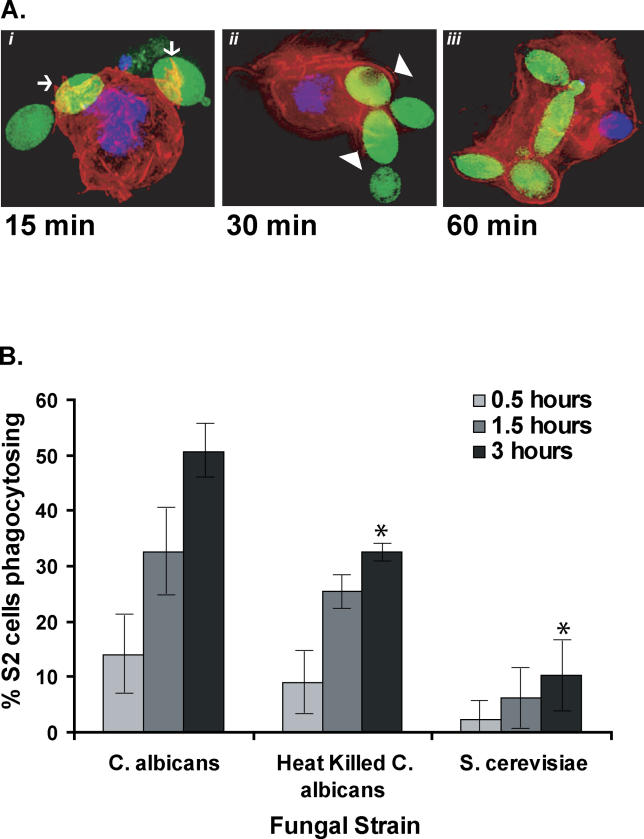
Phagocytosis of C. albicans by Drosophila S2 Cells(A) The Drosophila hemocyte-like S2 cell line phagocytoses C. albicans. S2 cells were co-incubated with GFP expressing C. albicans for the indicated times. Cells were fixed, and the filamentous actin of S2 cells was stained with rhodamine phalloidin and the S2 cell DNA with Hoechst 33258.(B) Quantification of phagocytosis of C. albicans and S. cerevisiae by S2 cells. S2 cells and the indicated fungal strain were co-incubated for various times, and the percentage of S2 cells that had phagocytosed one or more C. albicans was quantified by counting 50–100 S2 cells. The maximum time shown is 3 h, as the levels of phagocytosis did not significantly increase after this timepoint. Results are the average of four experiments, and the error bars indicate the standard deviation. As described in Materials and Methods, the 3-h results were evaluated for statistical significance using the t-test, assuming unequal variance. As indicated by the asterisks, the values for heat-killed C. albicans and S. cerevisiae were statistically different from that of live C. albicans, with a confidence level p < 0.01.